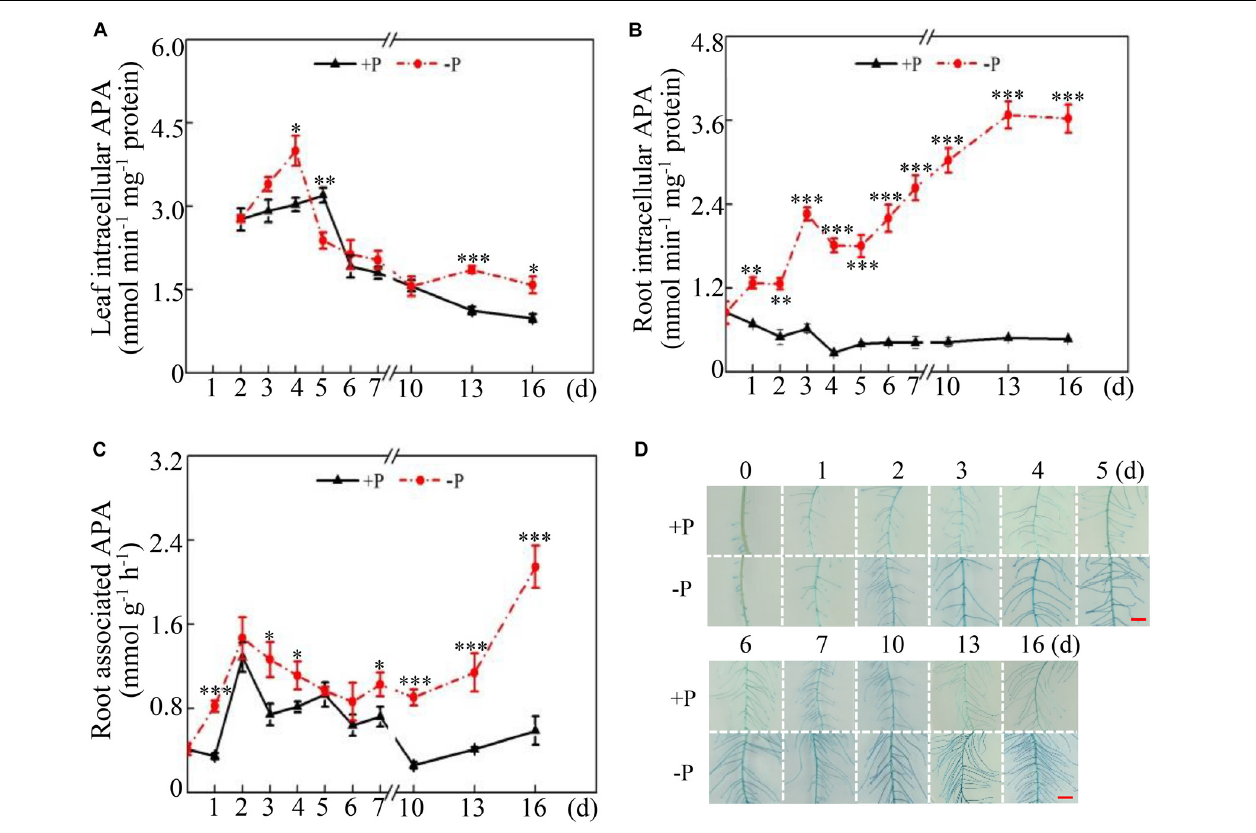
FIGURE 2 | Dynamic changes in intracellular and root-associated APase activities in soybean. (A) Leaf intracellular APase activities. (B) Root intracellular APase activities. (C) Root-associated APase activities. (D) Root-associated APase activities detected by BCIP staining. Soybean seedlings were grown in nutrient solution supplemented with 5 µ M (–P) or 250 µ M (+P) KH 2 PO 4 . Intracellular and associated APase activities were dynamically measured. Data are means of four replicates with standard errors. Asterisks indicate significant differences between the –P and +P treatments by according to Student’s t -test: ∗ P < 0.05; ∗∗ 0.001 < P < 0.01; ∗∗∗ P < 0.001. The bars = 1